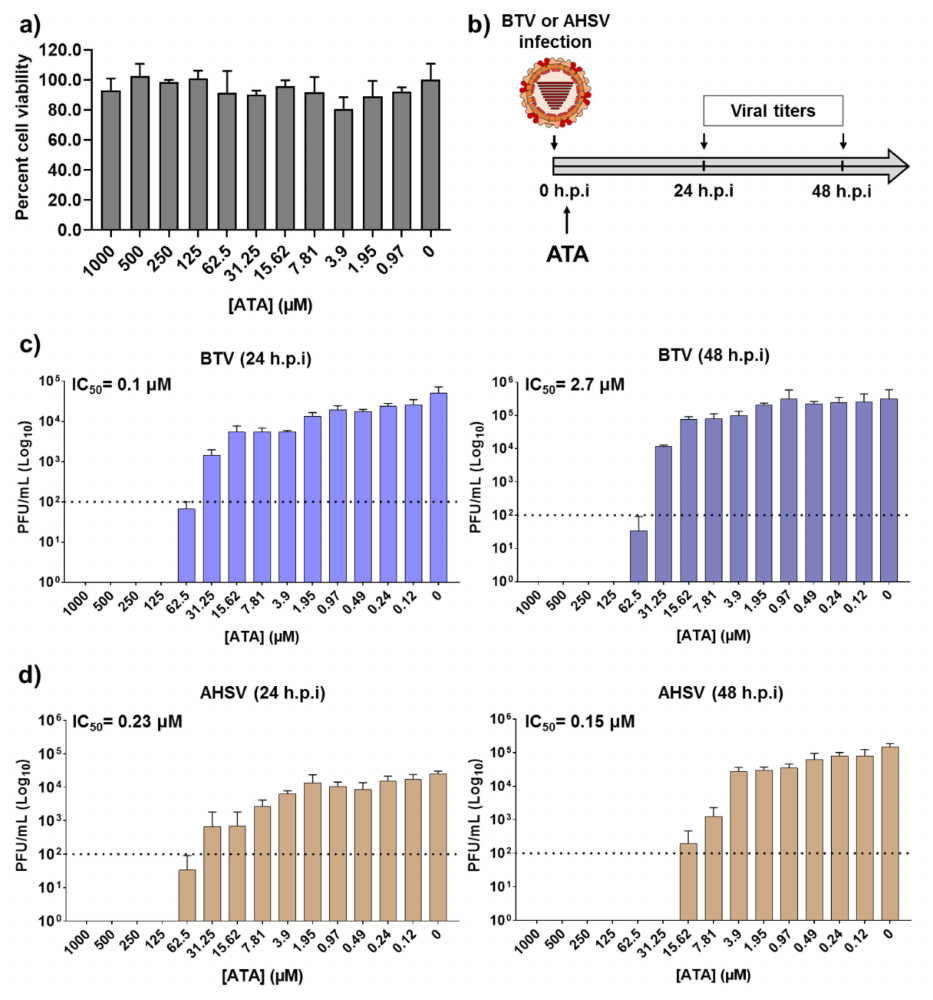
Figure 2. Inhibition of Bluetongue virus (BTV) and African horse sickness virus (AHSV) by ATA. ( a ) Cytotoxicity of ATA. Vero cells were treated with the indicated doses (two-fold dilutions, starting concentration 1000 µ M) of ATA. Cell viability was analyzed at 24 h after treatment. Data are expressed as mean and SD. ( b ) Schematic representation of the experimental design. Vero cells were infected (multiplicity of infection (MOI), 0.01) with BTV-4 ( c ) or AHSV-4 ( d ), and after 90 min of viral adsorption, the indicated concentrations (two-folds dilutions, starting concentration 1000 µ M) of ATA were added to the infection media (0 h.p.i.). At 24 (left) and 48 (right) h post-infection (h.p.i)., tissue culture supernatants were collected for virus titration by the plaque assay. The IC 50 is indicated. Data are expressed as mean and SD. Dotted lines indicate the limit of